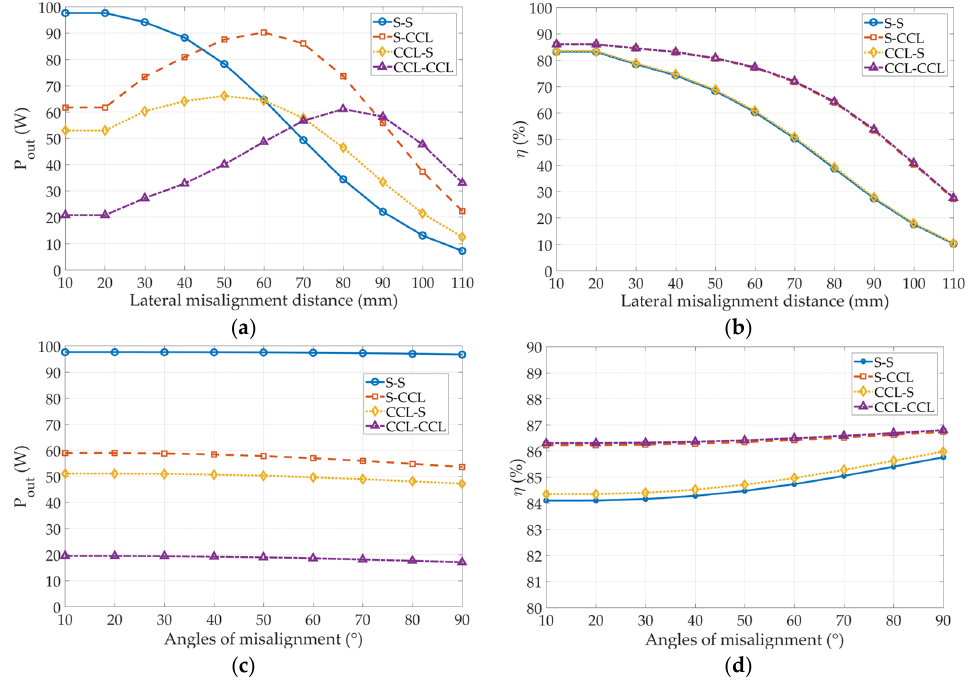
Figure 17. ( a ) Transmitting powers and ( b ) power transfer efficiencies for various topologies in lateral misalignment; ( c ) transmitting powers and ( d ) power transfer efficiencies for various topologies in angled misalignment.